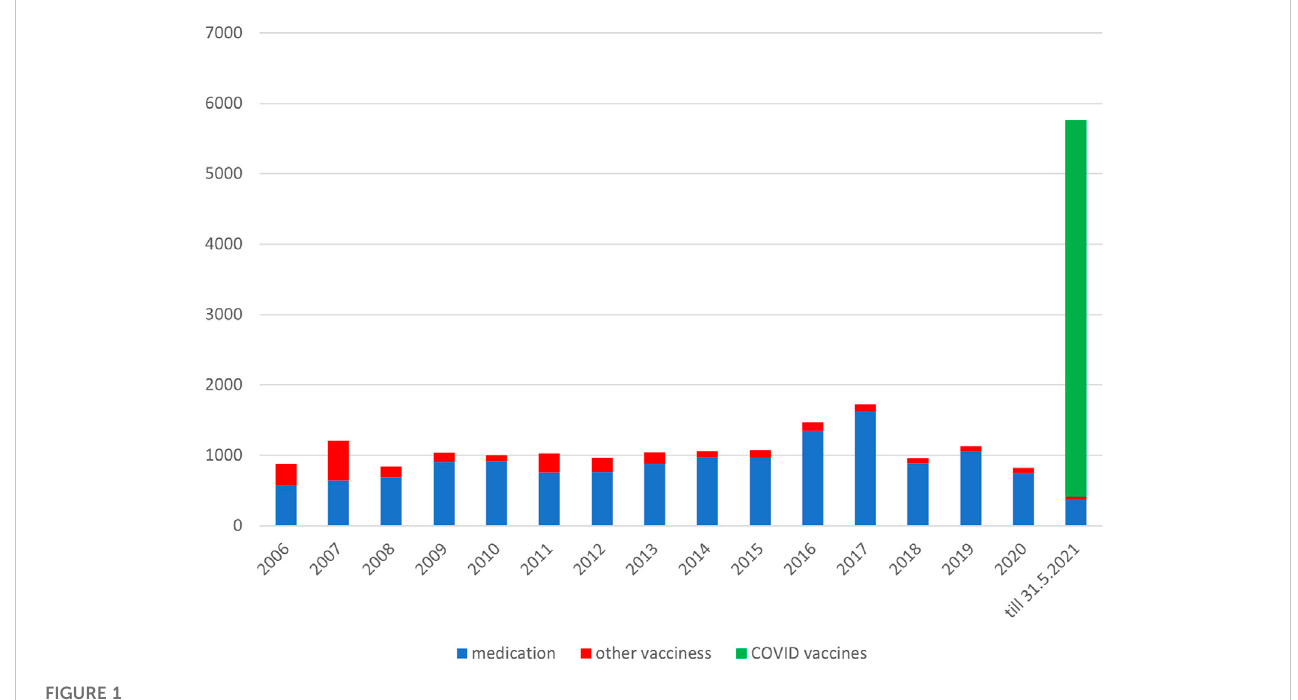
Reported suspected ARs from 1 January 2006 to 31 May